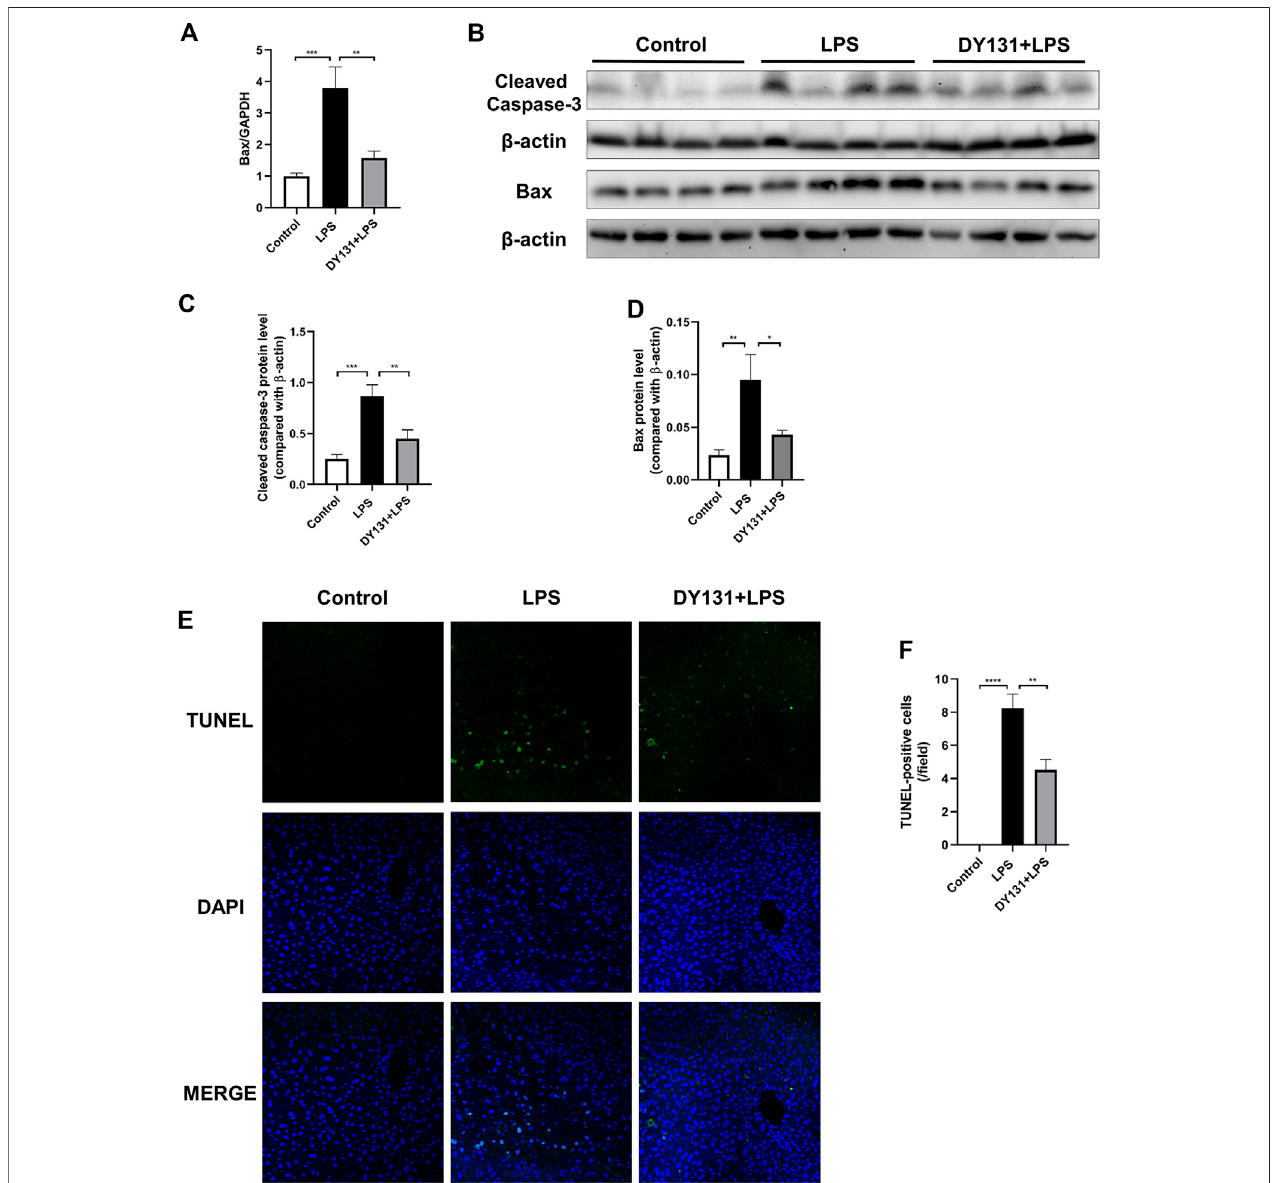
FIGURE 5 | DY131 attenuated LPS-induced hepatic apoptosis. (A) mRNA expression of Bax determined by qRT-PCR (n (cid:1) 10 in each group). (B) Protein levels of cleavedcaspase-3andBaxdetectedbyWesternblotting(n (cid:1) 8ineachgroup). (C,D) Quantitativeanalysesofcleavedcaspase-3andBaxbydensitometry(n (cid:1) 8ineach group). (E) Representative images of TUNEL staining of liver tissue sections. Green staining indicated apoptotic cells and DAPI staining was used to visualize nuclei (magni fi cation × 200,scalebar:50 μ m,n (cid:1) 4ineachgroup). (F) NumberofTUNEL-positivecellsper fi eldindifferentgroups.Datawerepresentedasmeans ±